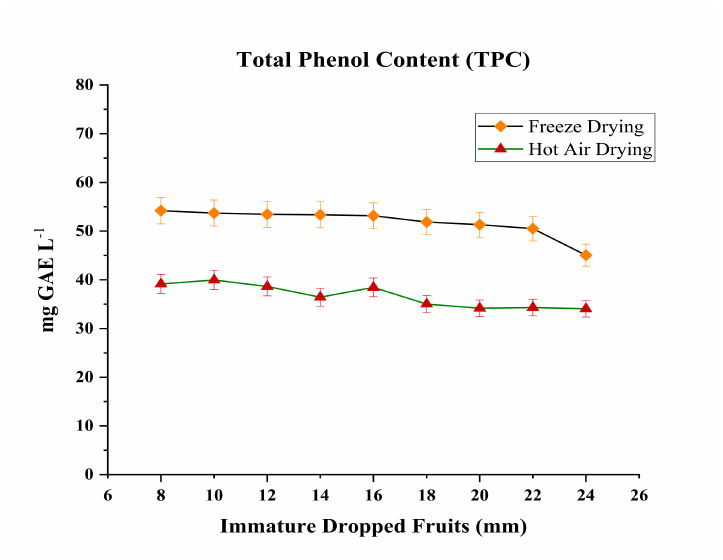
Figure 4. Total phenol content (TPC) of immature mandarin ( Citrus reticulata Blanco) dropped fruits after freeze drying and hot air oven